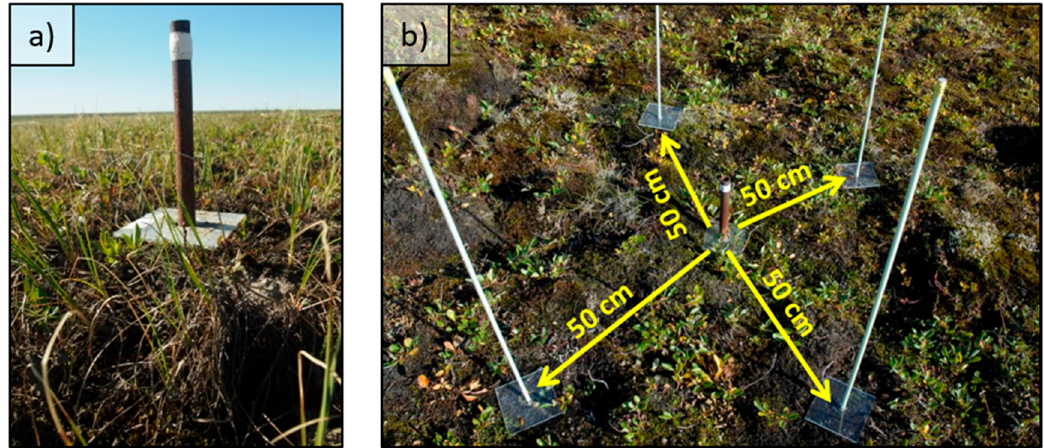
Figure 2. ( a ) Example of a measurement site with a metal pipe set-up; ( b ) Example of a measurement site with fiberglass rods arranged around a metal pipe (station 9, August 2014). Distance from each fiberglass pole to the metal pipe is about 50 cm. Table 1. Periods of field measurements.